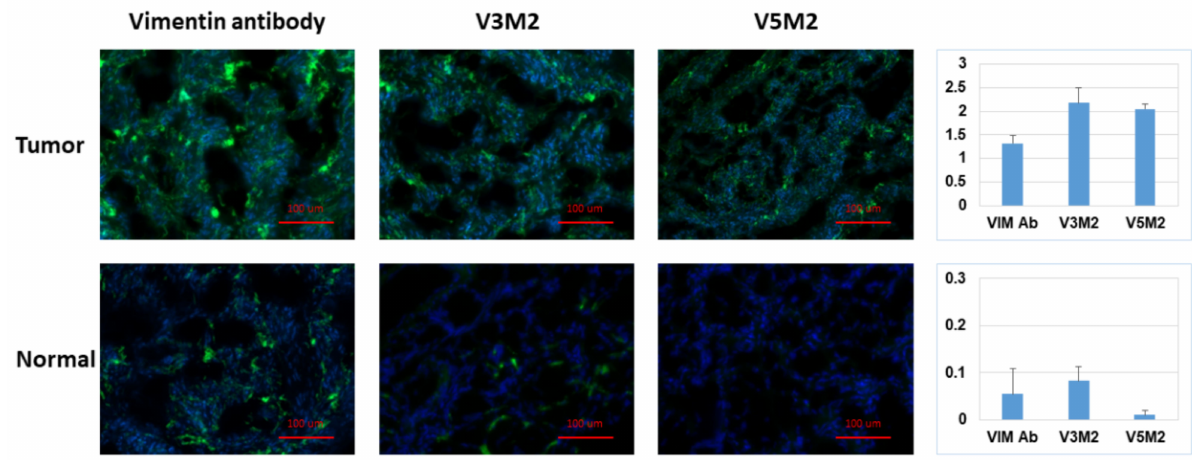
Figure 6. Detection of vimentin expression in human ovarian tumor tissue. Tissue sections of human ovarian tumor or normal ovarian tissue were incubated with biotinylated V3M2 or V5M2 at a concentration of 250 nM, followed by streptavidin-FITC to detect their binding affinity. Anti-human vimentin antibody was also used as a positive control for both ovarian tumor tissue and normal ovarian tissue. Images are representative of three samples of ovarian tumor or normal ovarian tissue. Fluorescence intensity is quantified by normalizing the fluorescence intensity of pixel per area (intensity of motif/intensity of DAPI) and presented as a bar graph with mean ± SE of three replicates. Hoechst 33,342 was used to stain the cell nuclei